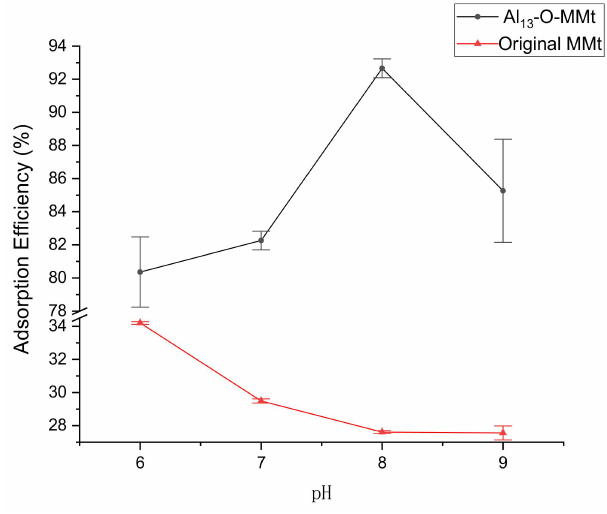
Figure 3. Adsorption efficiency (%) of MMt and Al 13 -O-MMt for phosphorus at different pH values.